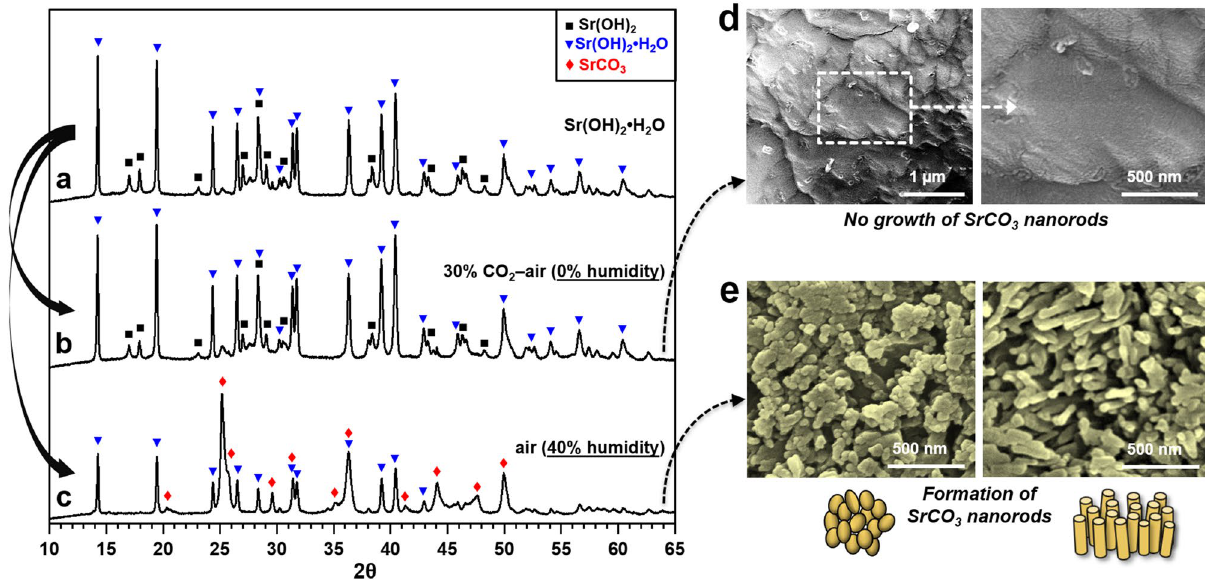
Figure 2. XRD patterns of SrO before and after exposure to ambient room air (1.2% H 2 O present, and 400 ppm CO 2 ) and a CO 2 -air mixed gas (H 2 O absent, and 30% CO 2 ) for 24 h ( a – c ), and their corresponding SEM images ( d , e ). Note that the XRD pattern of SrO could not be properly recorded because SrO was readily hydrated by absorbing airborne moisture in the middle of XRD analysis; thus, Sr(OH) 2 and Sr(OH) 2 ·H 2 O were detected instead of SrO.